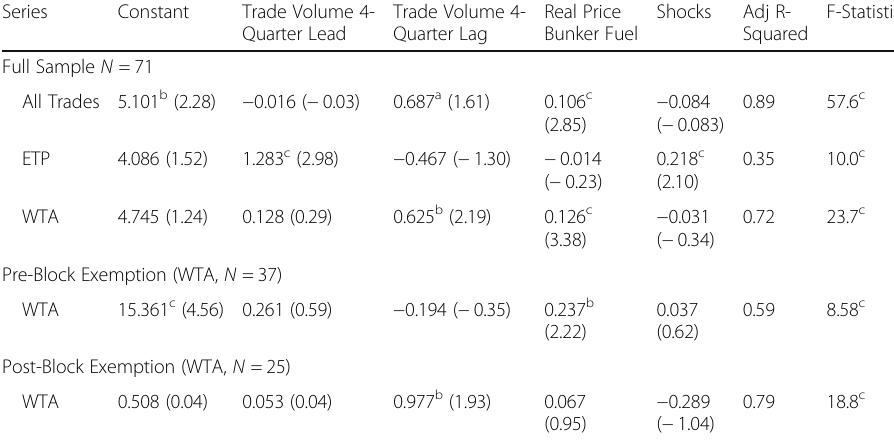
Table 7 Rational expectations forwards looking fair model: GMM Series Constant Trade Volume 4- Trade Volume 4- Quarter Lead Quarter